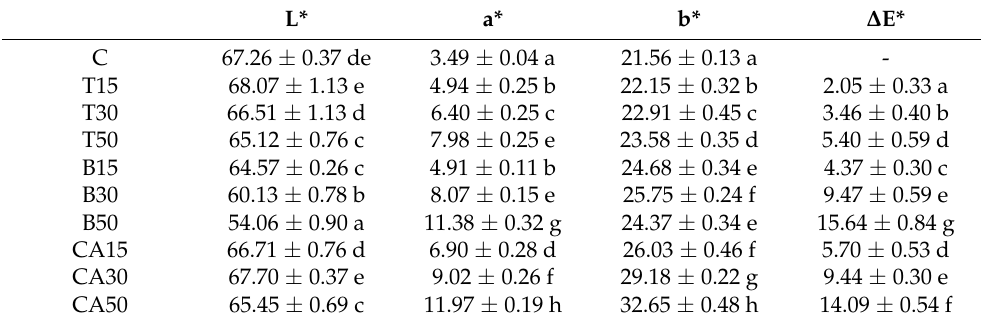
Table 3. Colorimetric coefficients in CIELAB scale of studied breads.